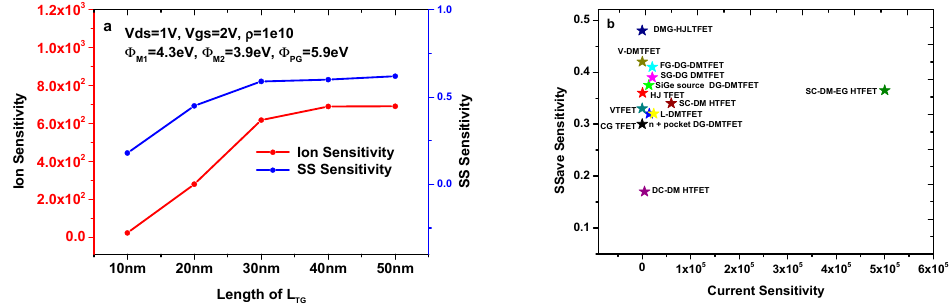
Figure 9. ( a ) Ion sensitivity and SS sensitivity for different L TG (k = 12); ( b ) comparison of different biosensors based on TFET.